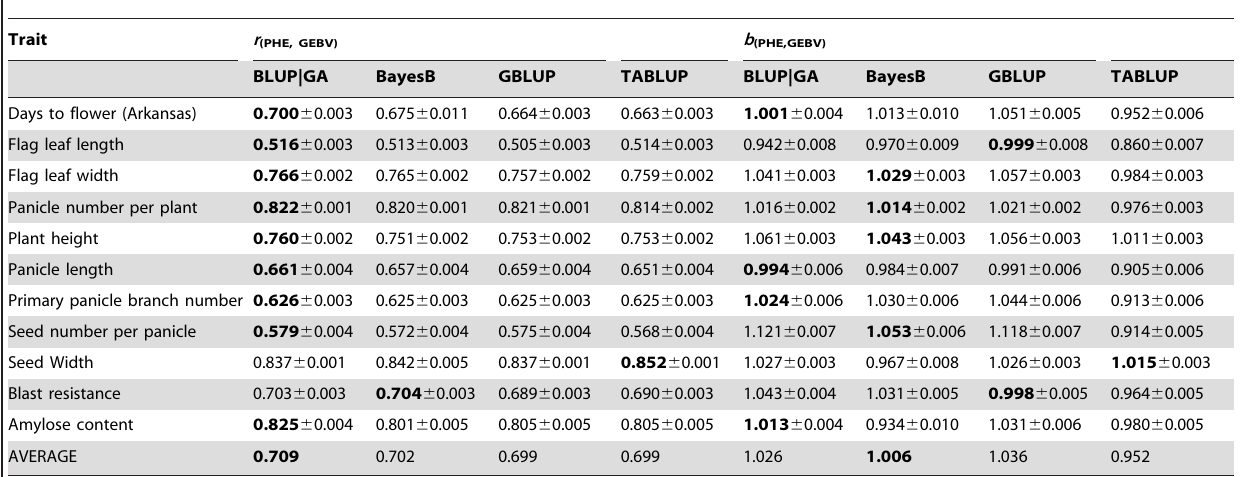
Table 4. Accuracy and unbiasedness of WGP for rice.